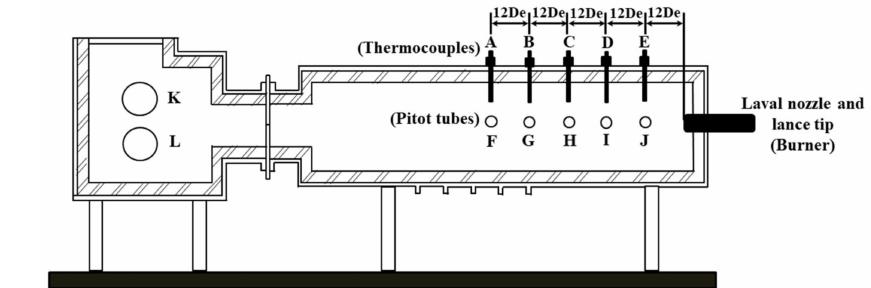
Figure 1. Schematic view of the experimental apparatus.